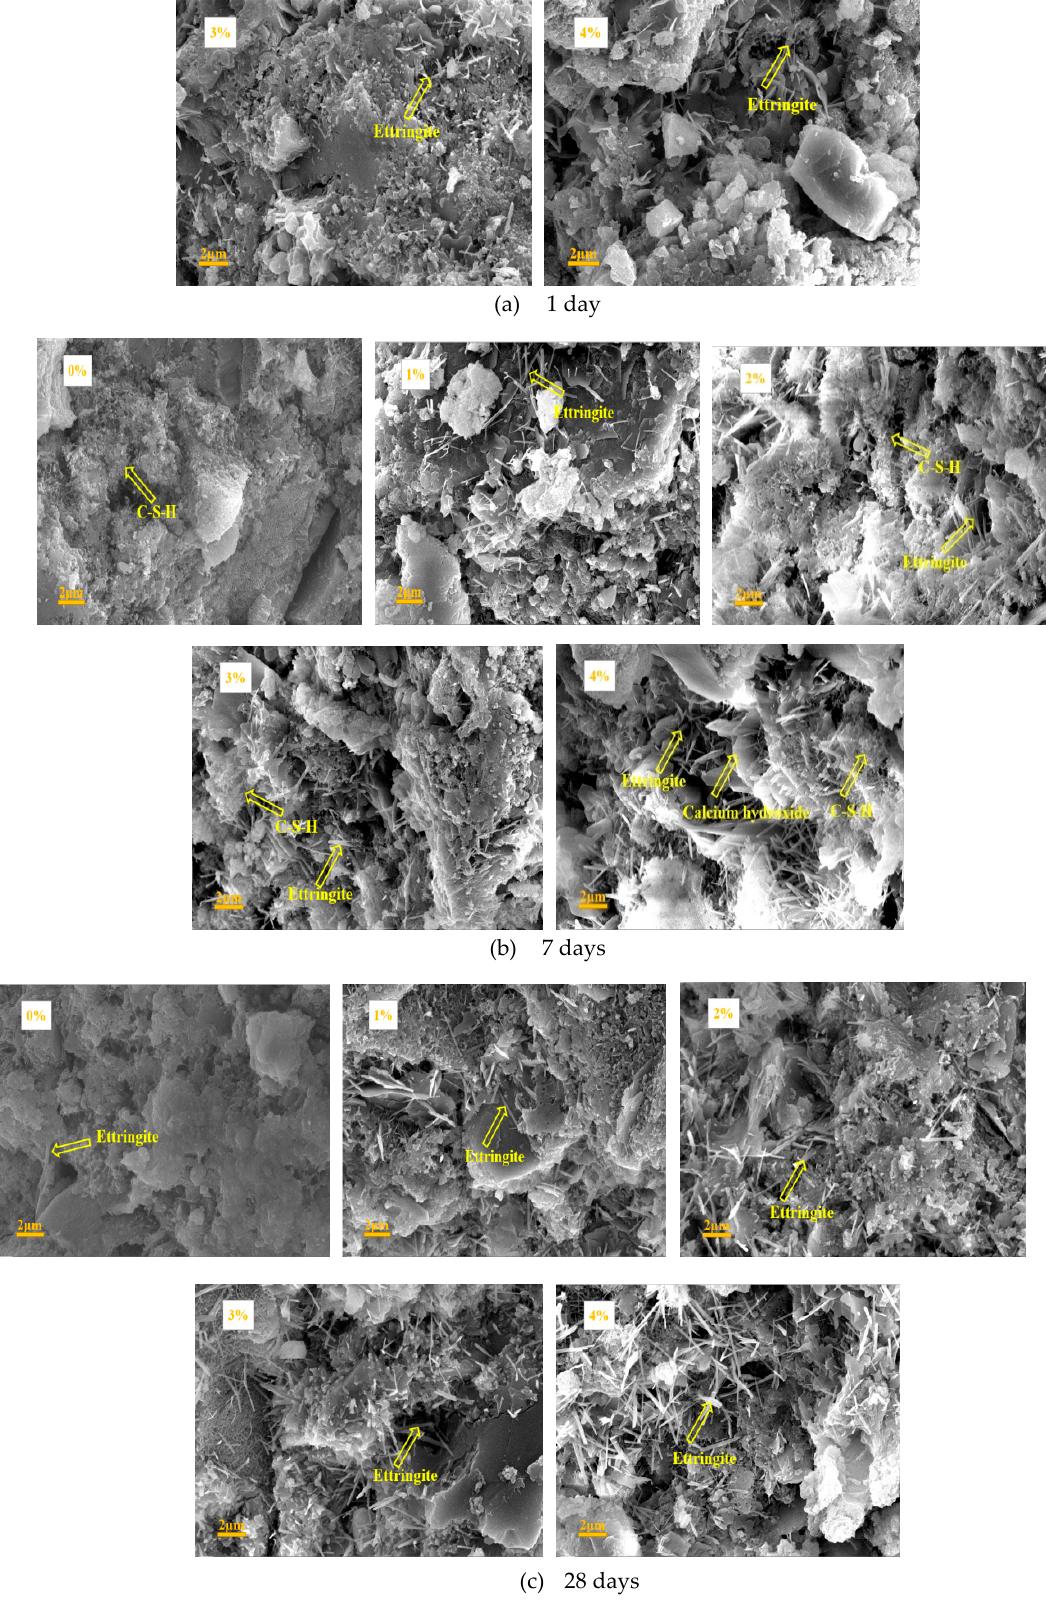
Figure 9. SEM results of the mixes with different contents of NaHCO 3 at ages of ( a ) 1, ( b ) 7, and ( c ) 28 days.